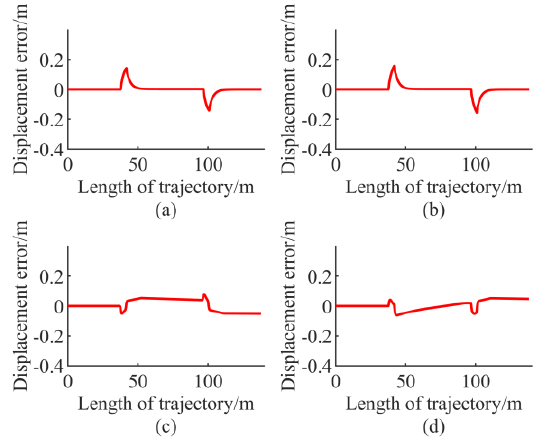
Figure 4. The displacement error when velocity is 2 m/s. ( a ) LMPC. ( b ) LEMPC. ( c ) NMPC. ( d ) NEMPC.